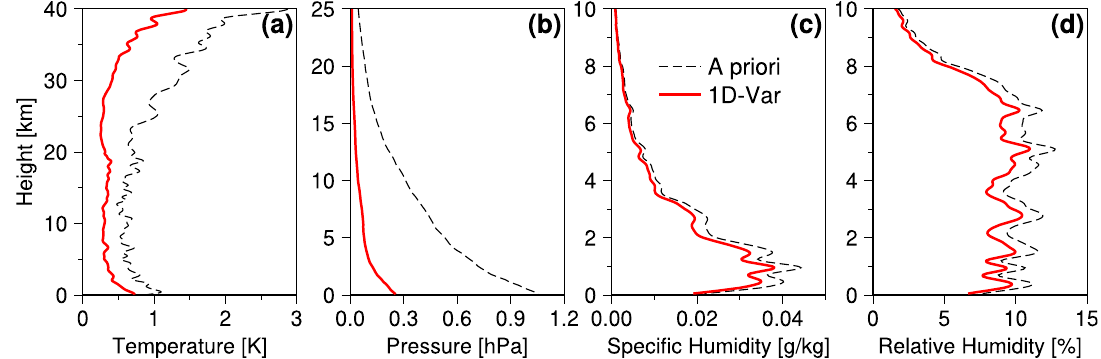
Figure 8. Errors of a priori profile (black dashed lines) and 1D-Var retrieval (red solid) for the Arctic case in Figure 7 in terms of: ( a ) temperature (°C), ( b ) pressure (hPa), ( c ) specific humidity (g kg −1 ), and ( d ) relative humidity (%). The error is defined as the standard deviation from the known truth.